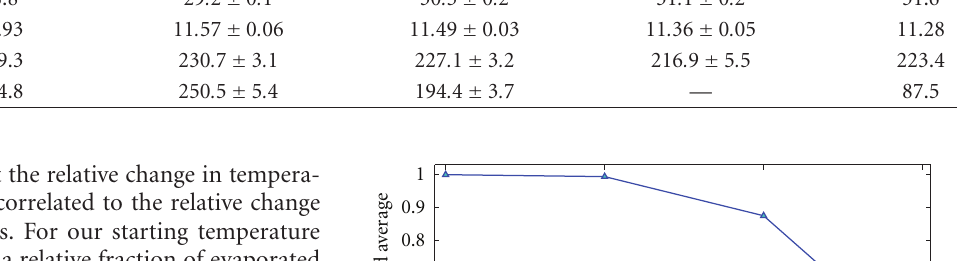
Table 2: Comparison of structural properties of the protein in various environments, averaged over the last 3ns of the simulation. Except for the bulk water simulation, averages over 3 simulations are shown. The crystal simulations show almost vanishing fluctuations, except for the RMSD. Bulk water Thick shell Thin shell Vacuum crystal RMSD [ ˚A]